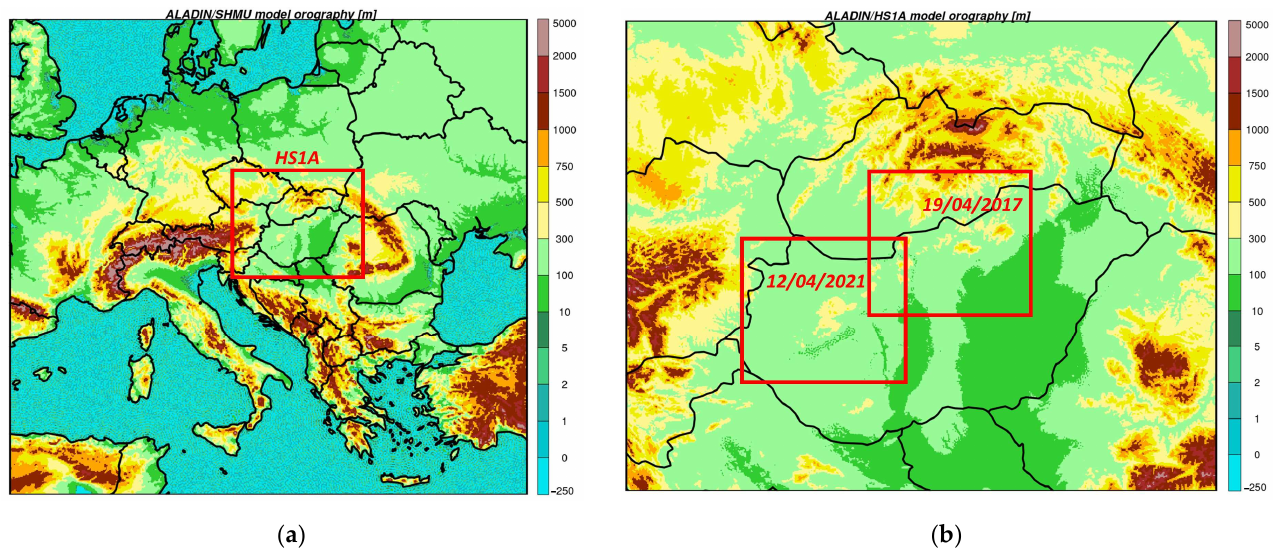
Figure 6. ( a ) Domain and orography (in m a.s.l.) of the ALADIN/SHMU model. The HS1A rectangle shows the position and size of the domain for the high resolution runs. The map depicts area between 2.32 ◦ E, 33.78 ◦ N (southwestern corner) and 39.05 ◦ E, 55.87 ◦ N (northeastern corner); ( b ) as in ( a ) but for the ALADIN/HS1A high resolution model version. The rectangles show the position and size of regions shown in Figures in the Section 4, concerning wet snow situations of 19–20 April 2017 (right rectangle) and 12–13 April 2021 (left rectangle). The map depicts area between 14.69 ◦ E, 45.17 ◦ N (southwestern corner) and 24.18 ◦ E, 50.23 ◦ N (northeastern corner).